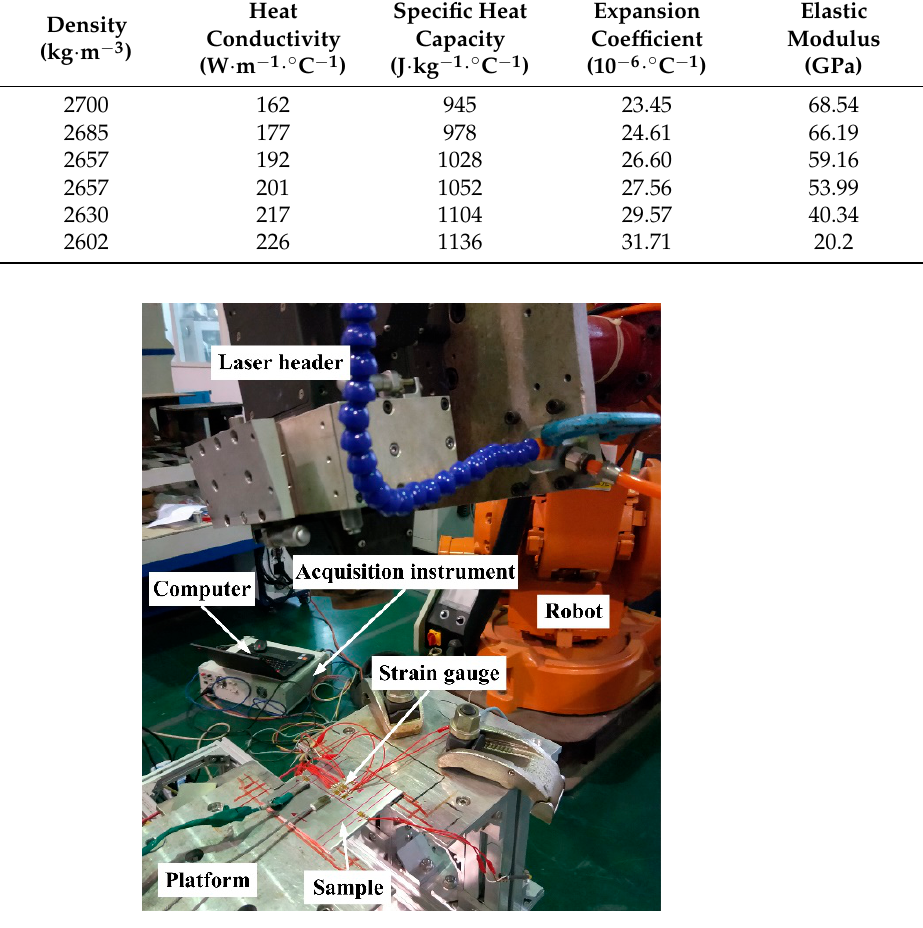
Figure 2. Laser welding